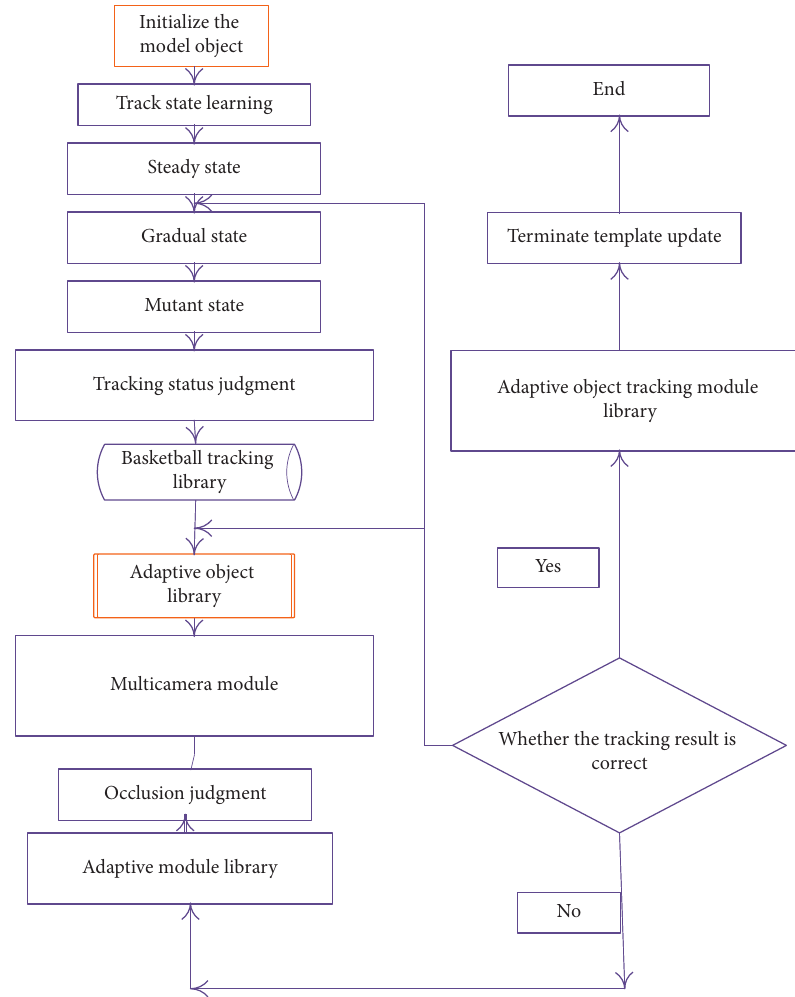
Figure 4: Self-learning update strategy simulation flowchart of the template